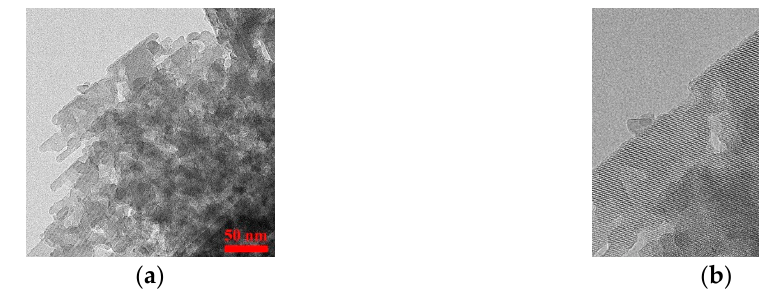
Figure 3. TEM images taken at low ( a ) and high ( b ) magnification of HTS-1s.